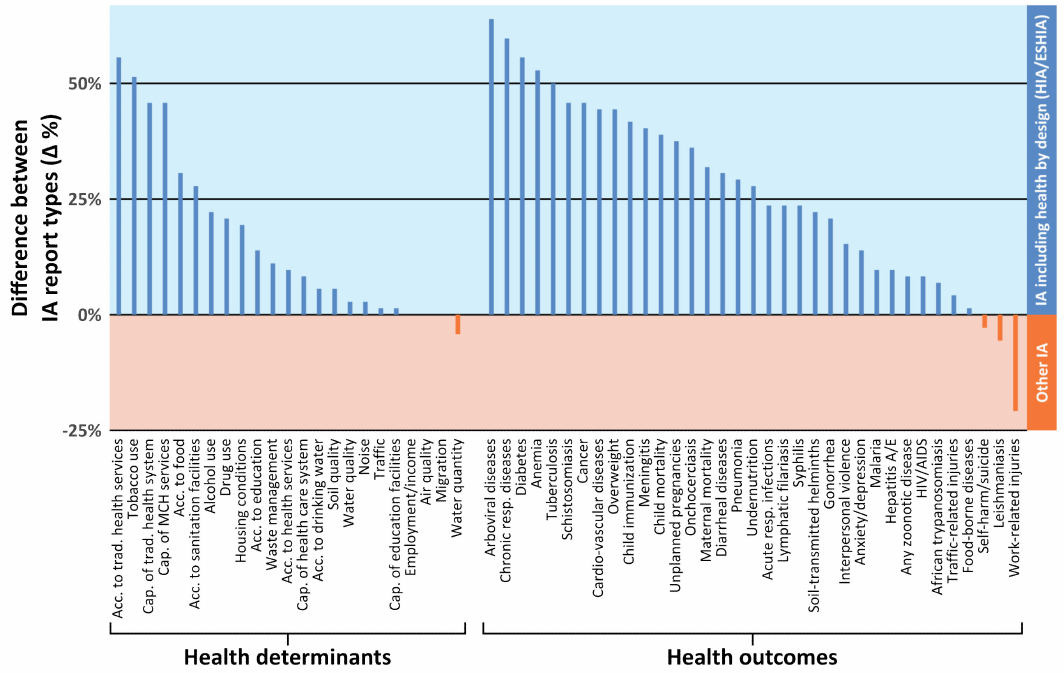
Figure 5. Di ff erence in percentages of impact assessment (IA) reports including the di ff erent health determinants and health outcomes between health-specific IA reports and non-health-specific IA reports. Blue bars indicate more frequent consideration of the respective health determinant / health outcome in health-specific IA reports; red bars indicate more frequent consideration in non-health-specific IA reports. Missing bars indicate a di ff erence of 0%. Acc. = access; Cap. = capacity; ESHIA = environmental, social and health impact assessment; HIA = health impact assessment; MCH = maternal and child health; resp. = respiratory; trad. =